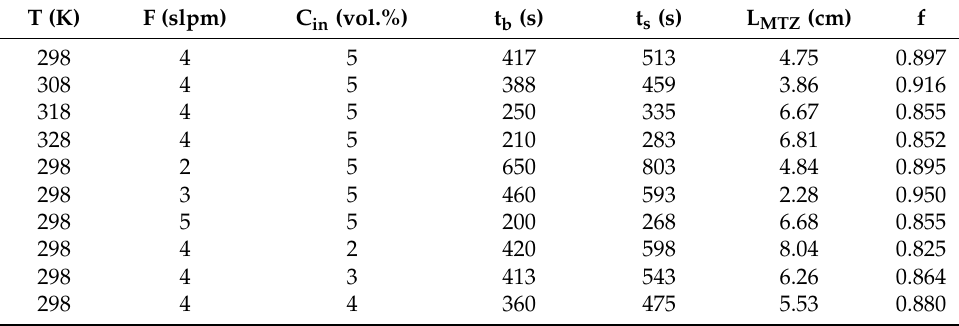
Table 7. Summary of characteristic CO 2 capture parameters of MS-3Å.